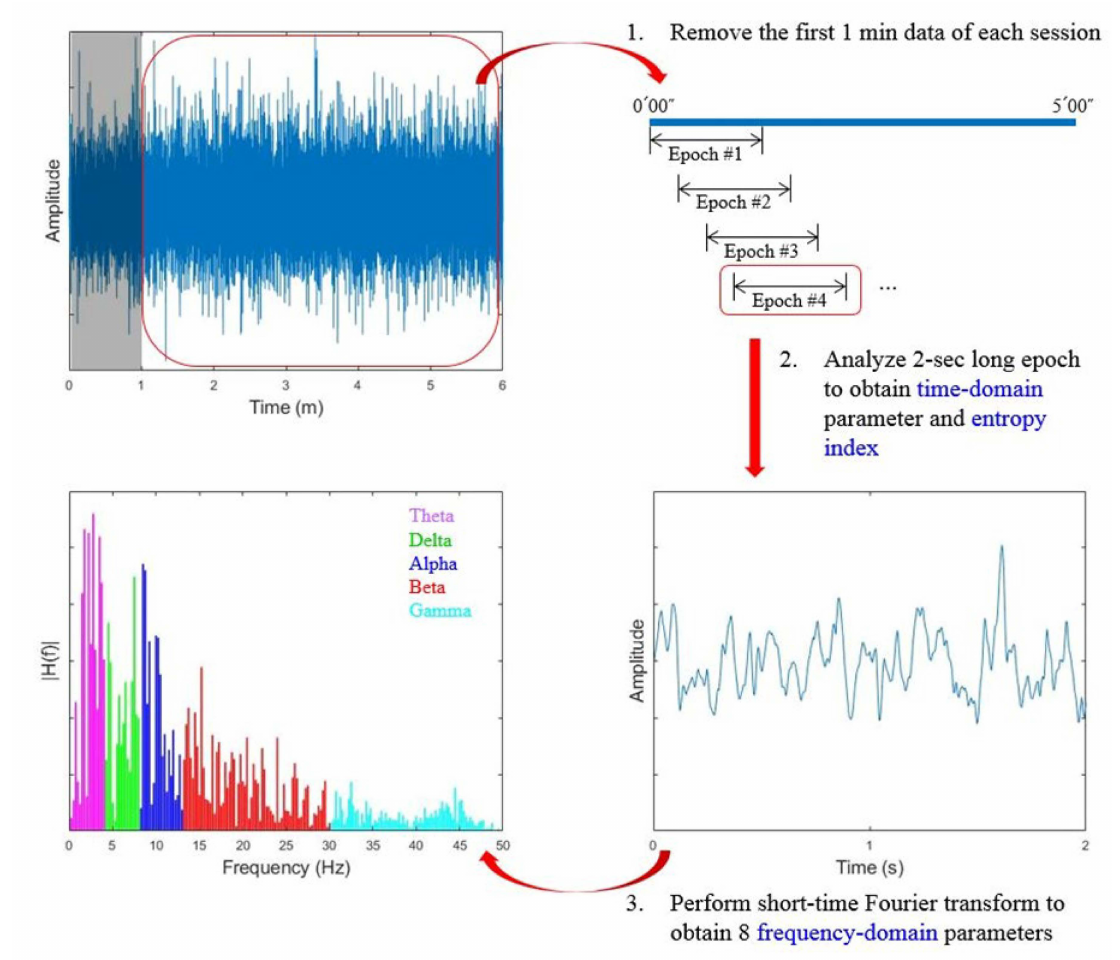
Figure A1. Pre-Processing of the EEG